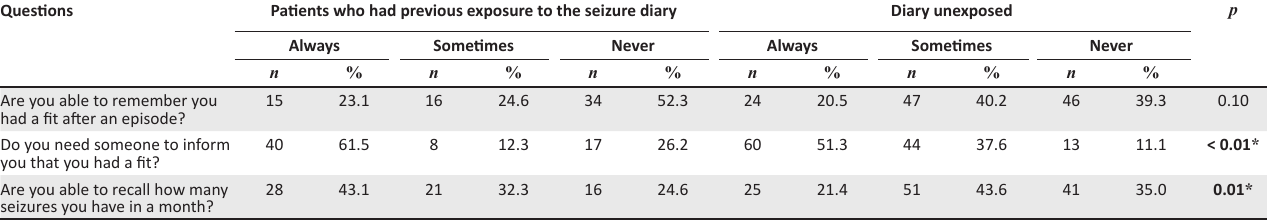
TABLE 3: Awareness and recall of seizures. Questions